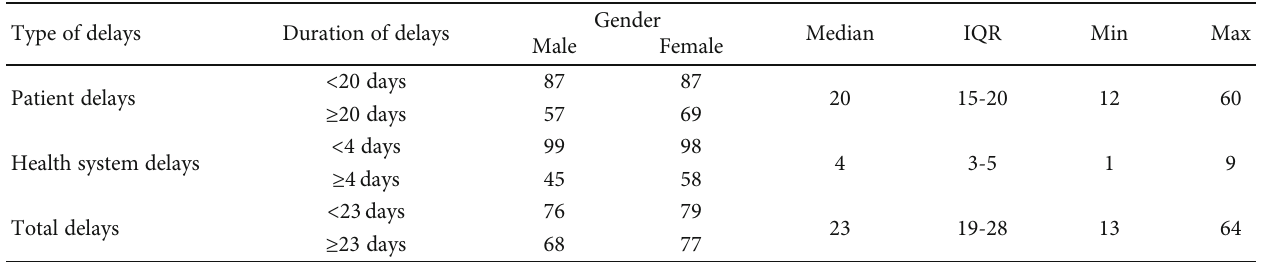
Table 2: The proportion of delays in tuberculosis treatment among DOTS patients at Debremarkos PHF, North West Ethiopia, 2018. Type of delays